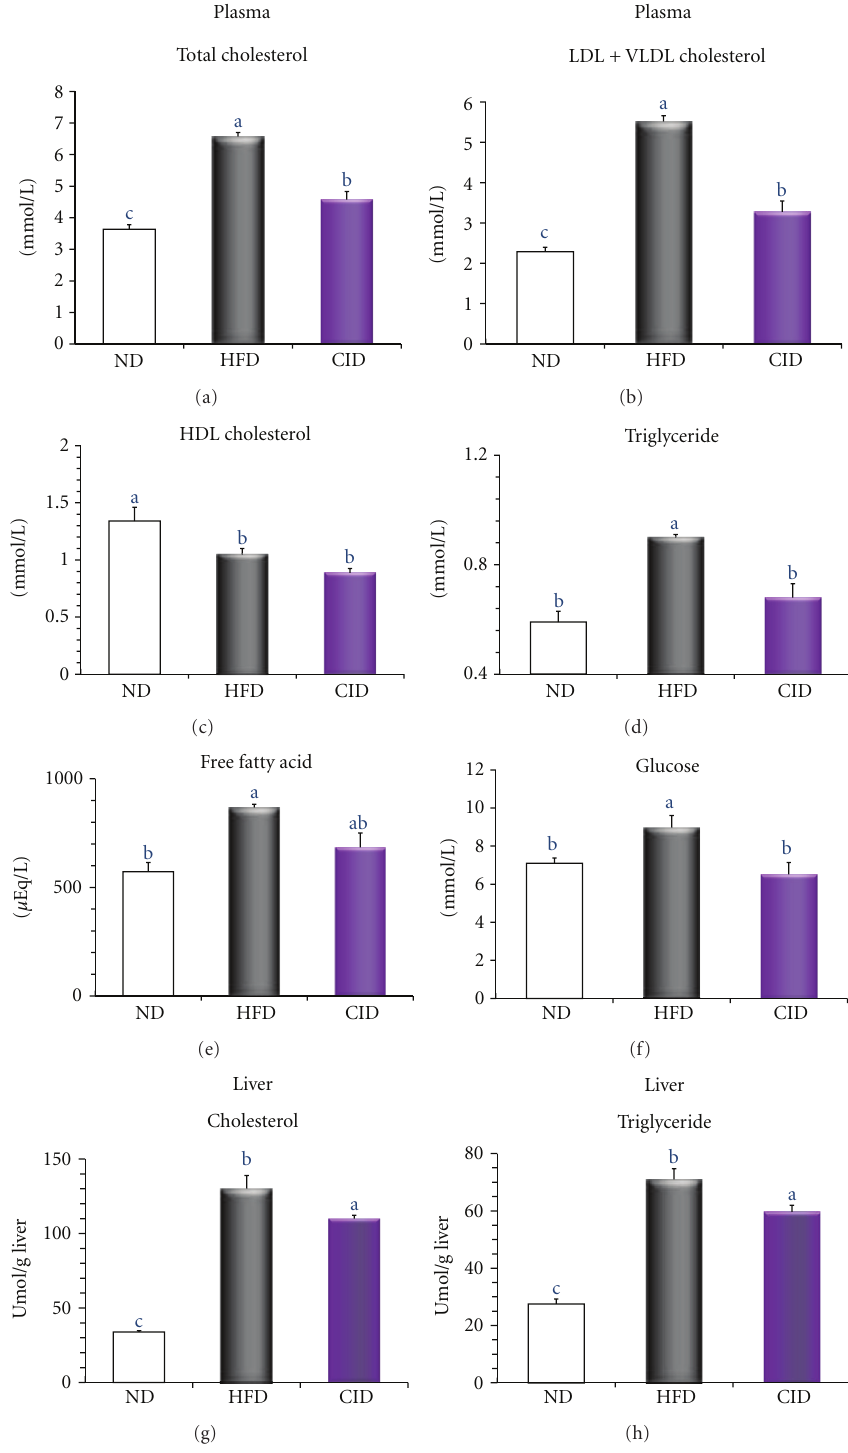
Figure 2: E ff ects of dietary cinchonine on plasma and liver biomarkers of the mice fed on the ND, HFD, or CID. Plasma (a) total cholesterol, (b) LDL+VLDL-cholesterol, (c) HDL cholesterol, (d) triglycerides, (e) free fatty acids, and (f) glucose levels. Hepatic (g) cholesterol and (h) triglyceride levels. Data are expressed as the mean ± SEM, n = 8, P < 0 . 05. Di ff erent letters are statistically di ff